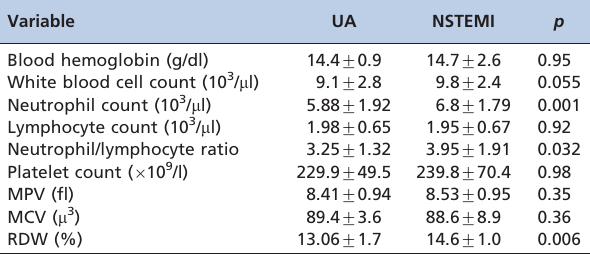
Table 2 - Blood parameters of the study population, stratified according to cardiac troponin I